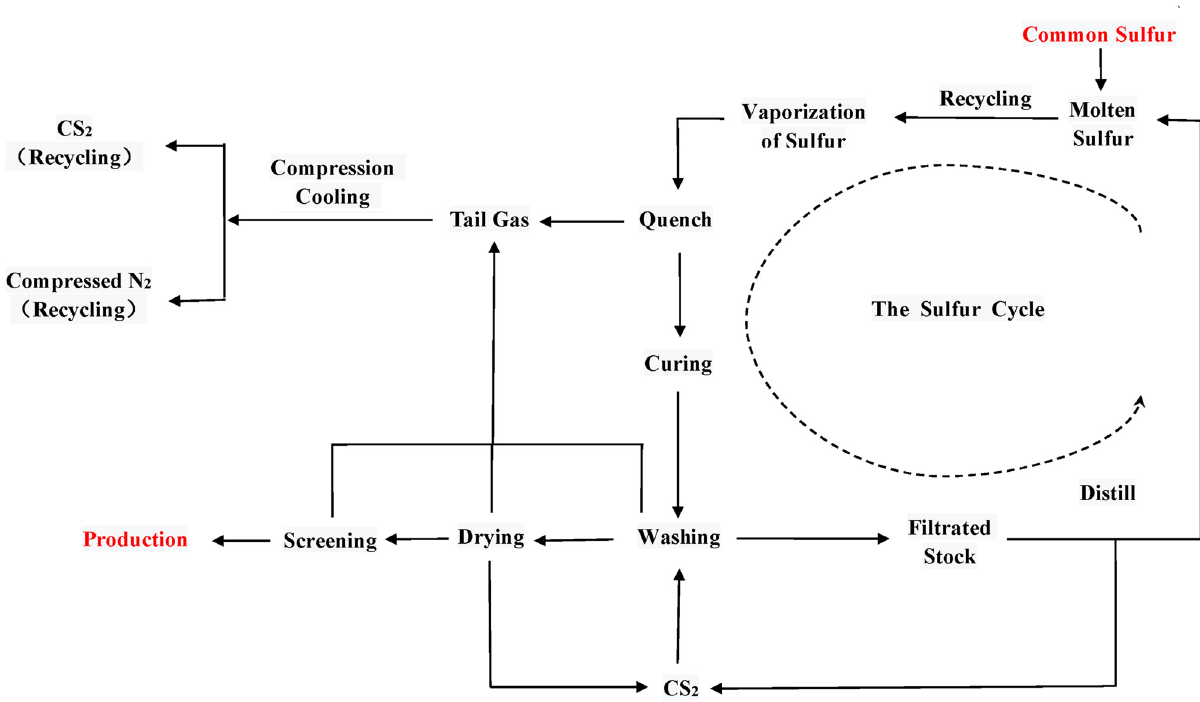
Figure 7: Diagram of IS production system